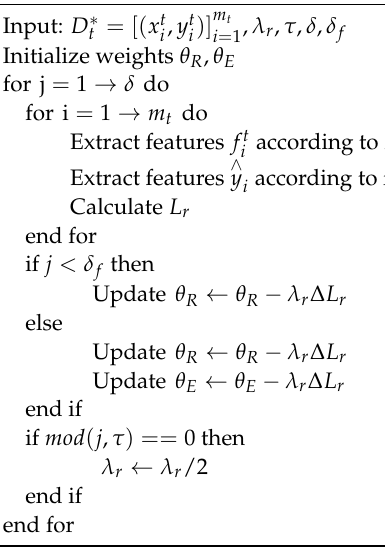
Algorithm 2 Regression task training algorithm